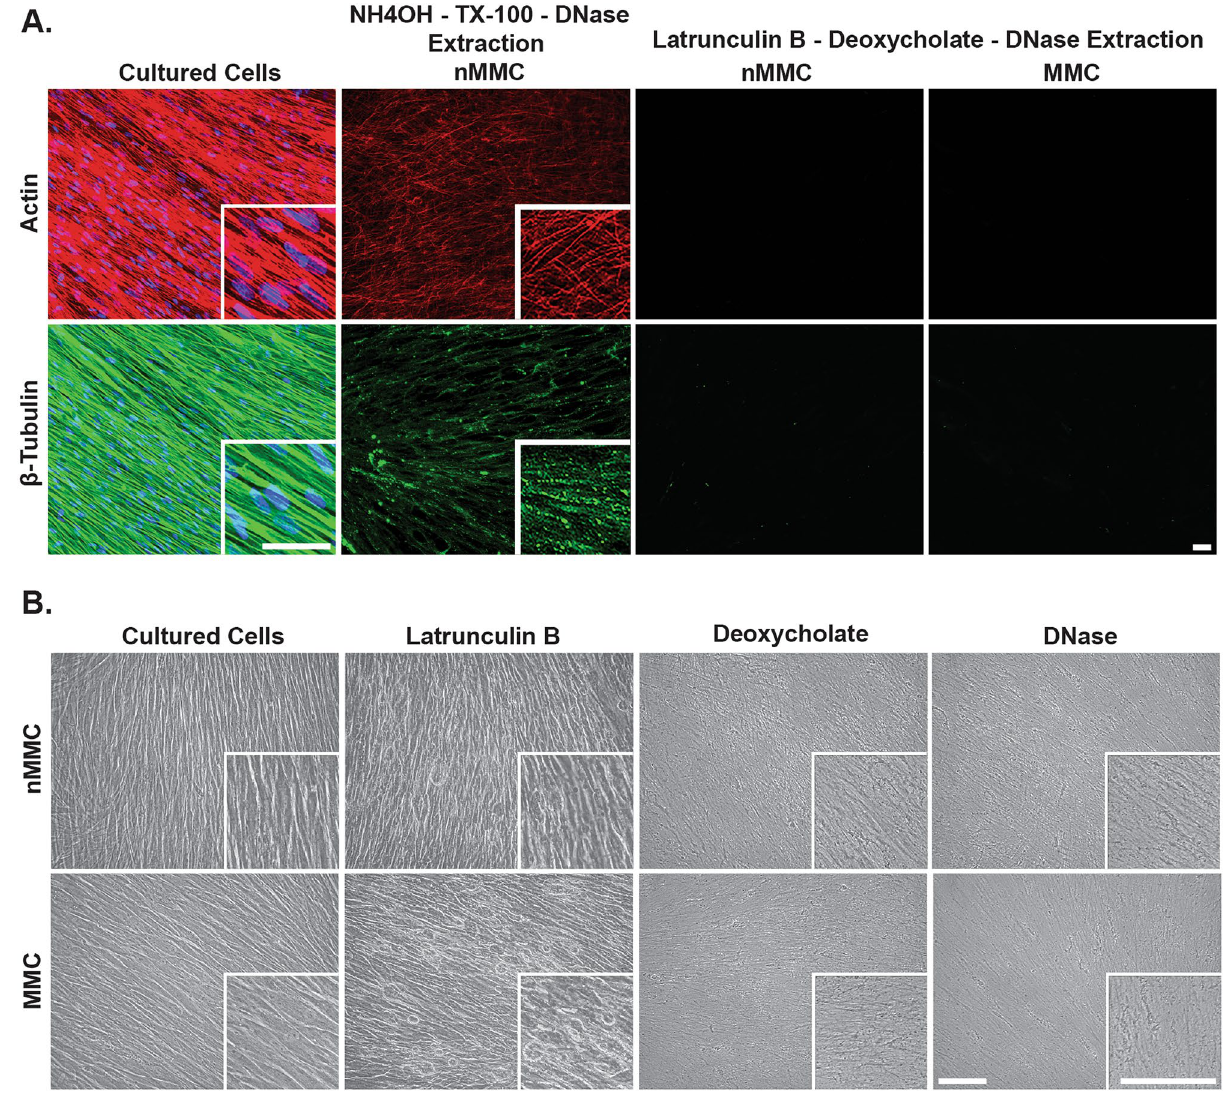
Figure 8. Characterization of decellularization methods. ( A ) Representative standardized immunofluorescence images of actin and β-tubulin in 14-day MMC and nMMC cultures before and after NH 4 OH-TX-100-DNase or latrunculin B-deoxycholate-DNase decellularization protocols. DNA was stained with DAPI nuclear stain (blue). ( B ) Representative standardized phase contrast microscope images of 14-day MMC and nMMC cultures before and after sequential incubations with latrunculin B, deoxycholate, and DNase. Inserts show higher magnification of select areas. Images in inserts are individually optimized for brightness/contrast. Magnification bars = 40